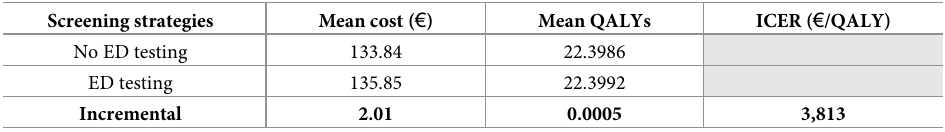
ICER = incremental cost-effectiveness